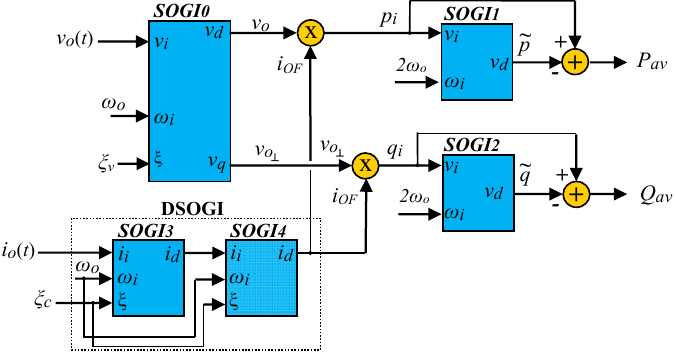
Figure 13. Scheme for the proposed P-Q calculation based on a DSOGI approach.